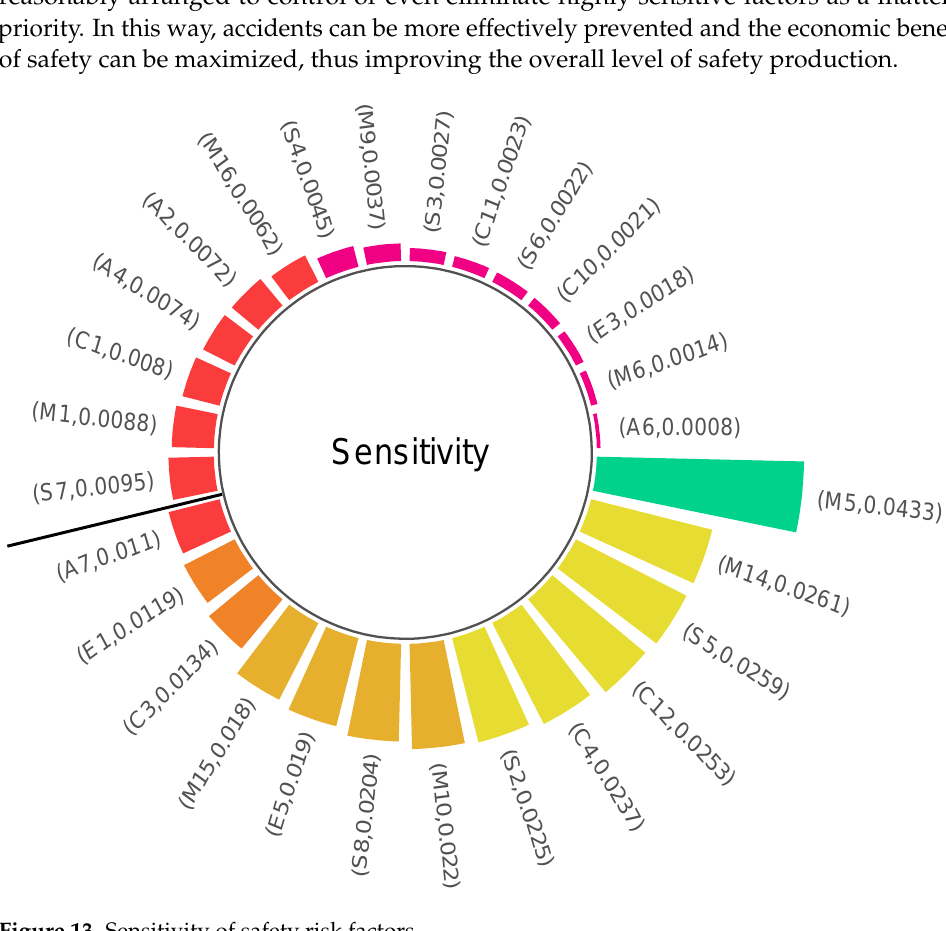
Figure 12. Result of Bayesian network sensitivity analysis.